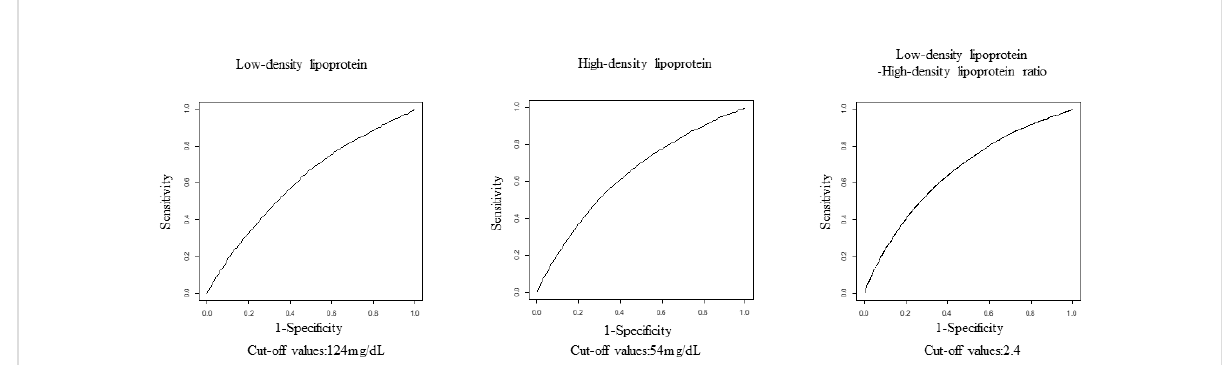
FIGURE 2 The receiver operating characteristic curve showing the ability of LDL, HDL, and LDL/HDL ratio to determine the incidence of diabetes after 10 years of follow-up. LDL, low-density lipoprotein; HDL, high-density